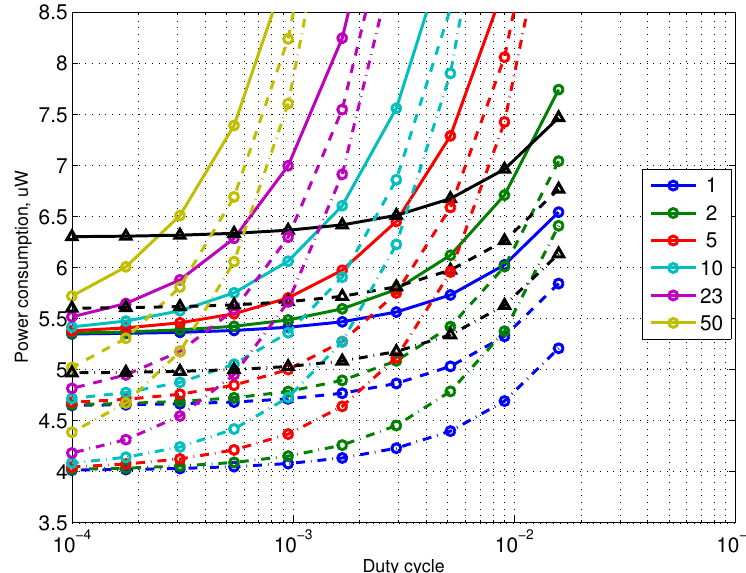
Figure 15. Detailed figure when M t = 1 and M r = 2, power consumption while operating with reloading the capacitor while operating with capacitor ( C s = 0.35 F). Non-WuR in black (without triangles), passive WuR in colors indicating number of nodes for different host duty cycles per node ( β (cid:48) w ). Semi-passive WuR in black with triangles. Line type indicates used SC leakage current model as —: upper , - - -: median, and -.-.-: